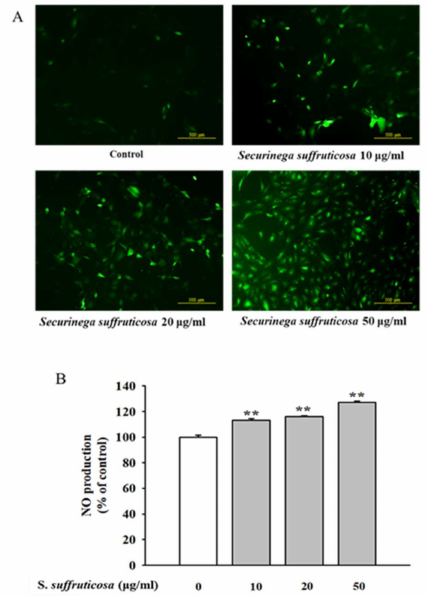
Figure 9. E ff ect of Securinega su ff ruticosa on nitrite production. ( A ) NO production was examined via fluorescence microscopy (original magnification × 100). ( B ) E ff ect of Securinega su ff ruticosa on NO production assayed as its stable reaction product nitrite with the Griess reaction. ** p < 0.01 vs.